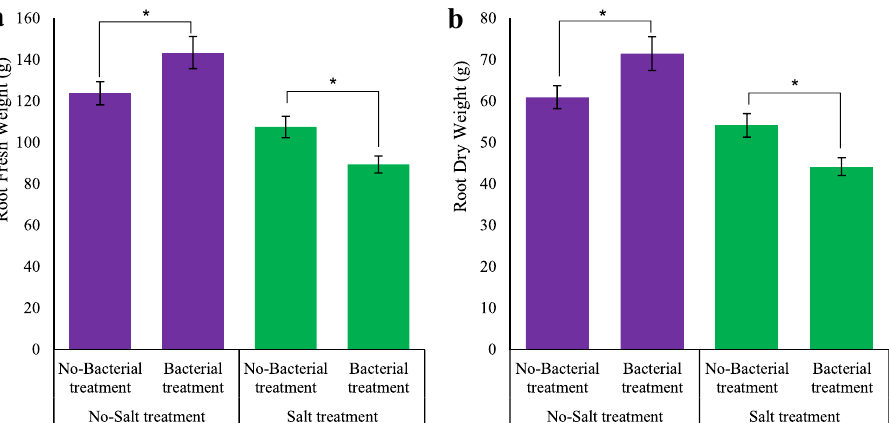
Figure 2. Measured parameters variation under studied treatments. ( a) Root fresh weight, ( b) Root dry weight. According to the analysis of variance, only multiple effects of Azotobacter and salinity showed a significant difference, just its mean comparison is shown. Mean values with the same letters are not significantly different ( p ≤ 0.05), Tukey test. Bars stand for standard error (SE).